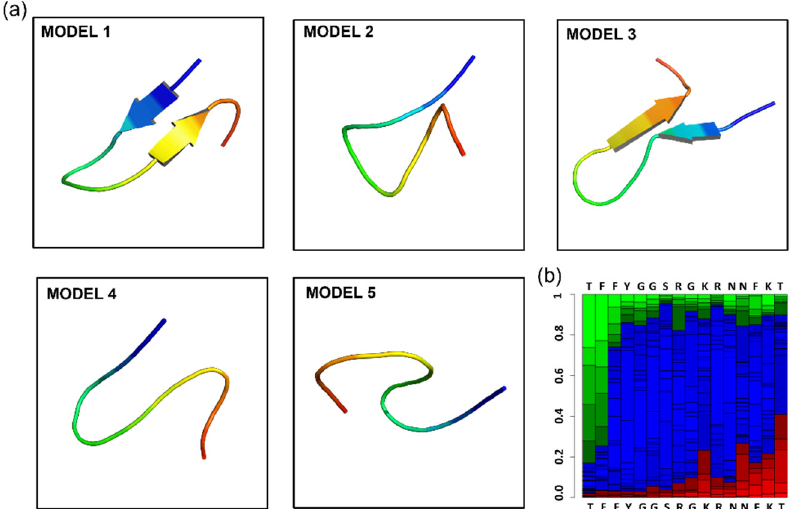
Figure 1. Prediction of angiopep-2 3D folding by PEP-FOLD3. ( a ) Five most probable 3D confor- mations of Angiopep-2; ( b ) 2D plot of folding probability in alpha-helix (green), β -sheet (red), or others (blue).